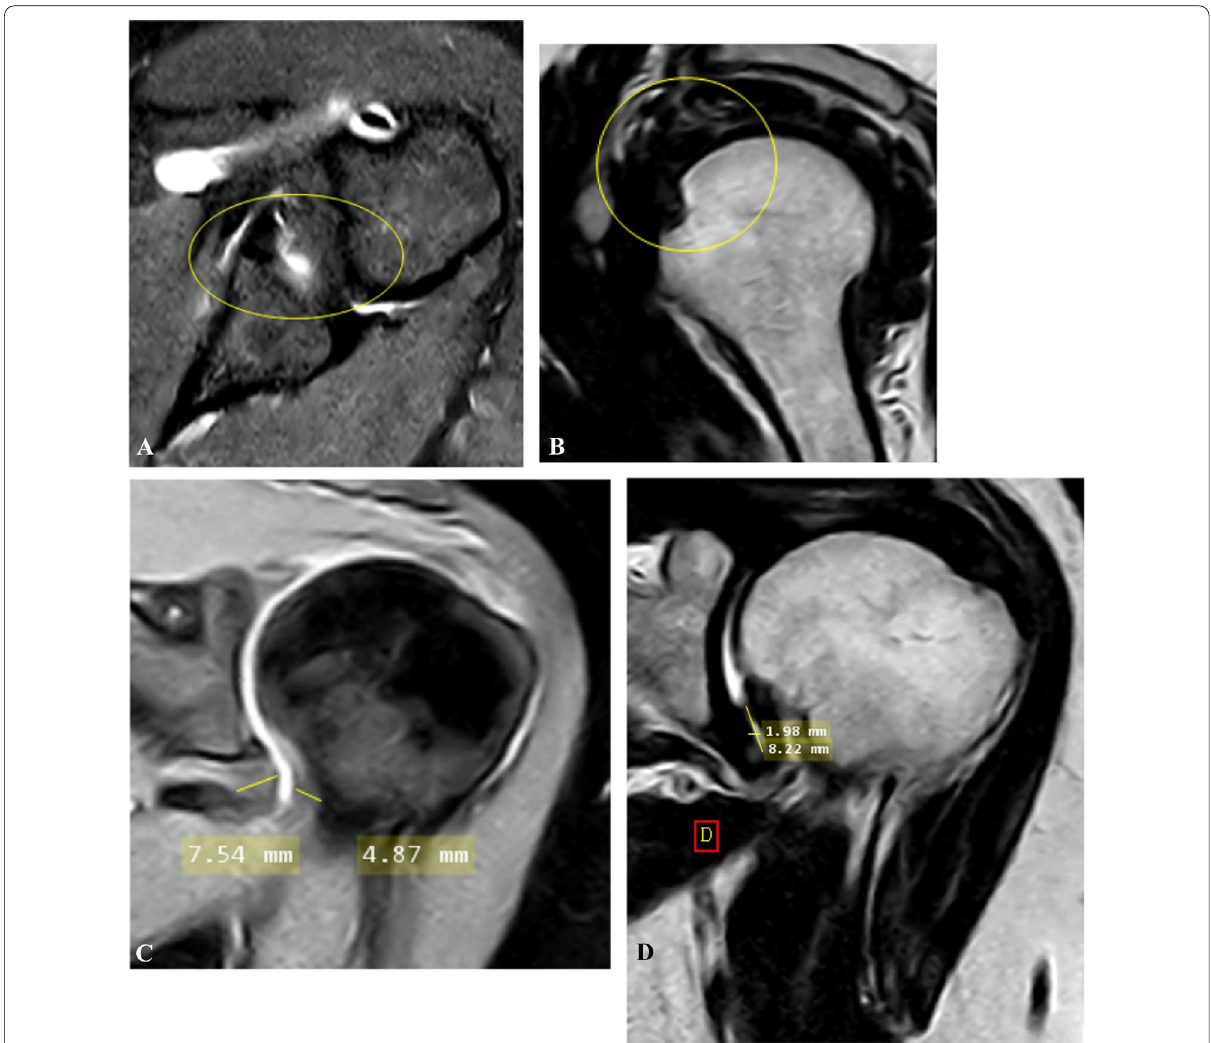
Fig. 5 A Oblique axial fat-suppressed PD-weightrd MR image shows anterior and posterior extracapsular edema (hyperintensity) (encircled area). B Oblique sagittal T2-weighted MR image shows partial obliteration of subcoracoid fat triangle (encircled area). C Oblique coronal fat-suppressed PD-weighted MR image shows measurement of thickest portion of joint capsule in humeral and glenoid portions of axillary recess. D Oblique coronal T2-weighted MR image shows measurement of maximal height and width of axillary